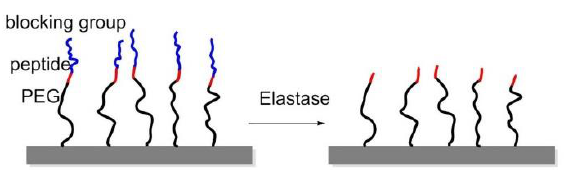
Figure 17. Enzyme-triggered polymers were immobilized on glass. The RGD peptide was blocked by Fmoc, amino acid, or polyethyleneglycol (PEG). Elastase can cleave the blocking group at a specific position thus exposing the RGD peptide, thereby improving cell adhesion.